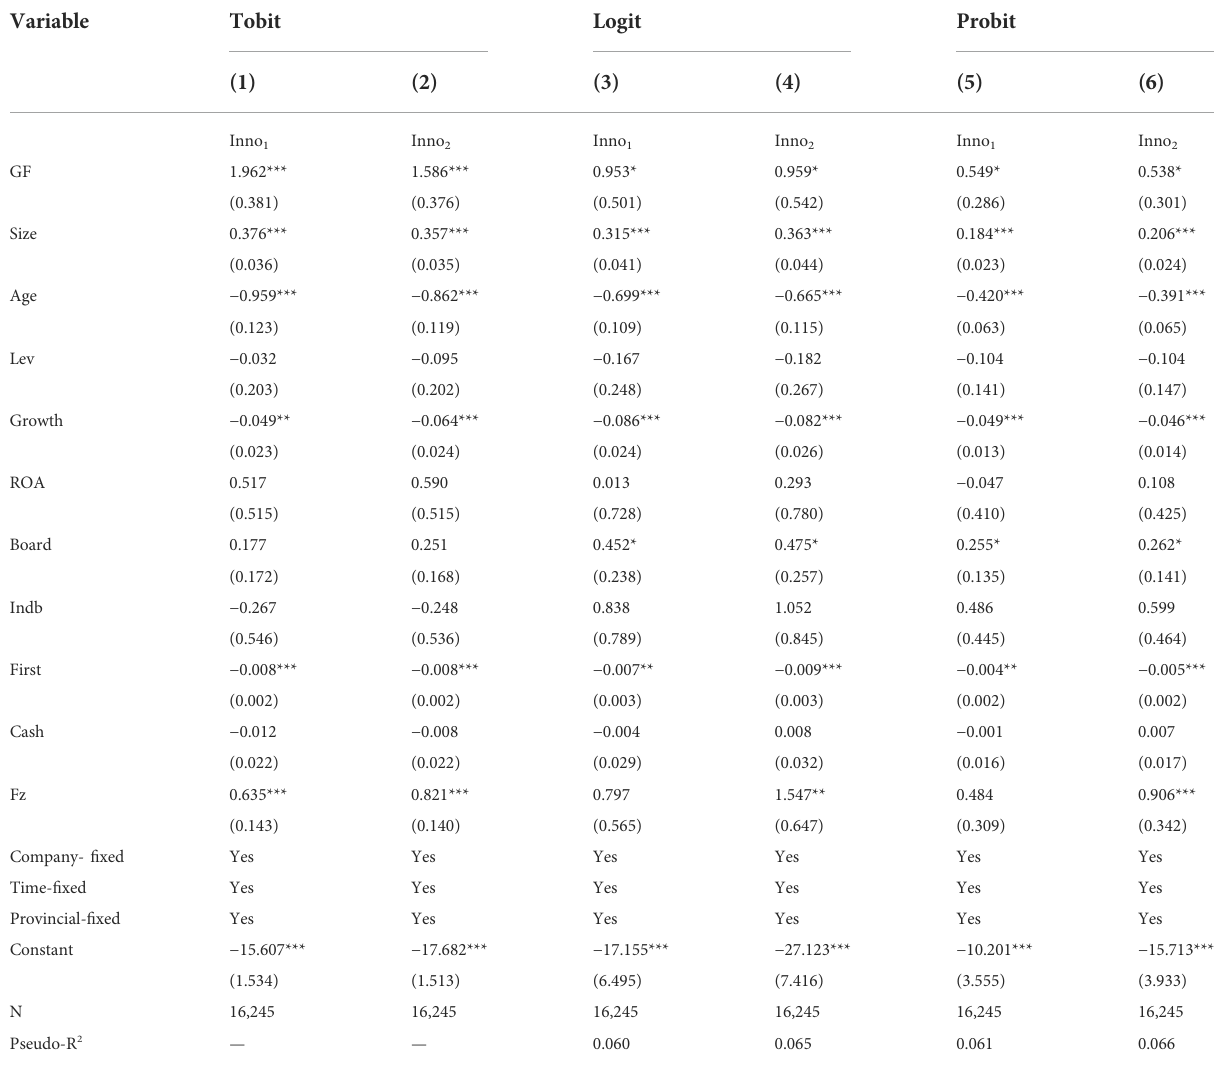
TABLE 4 Robustness test: alternative regression method.